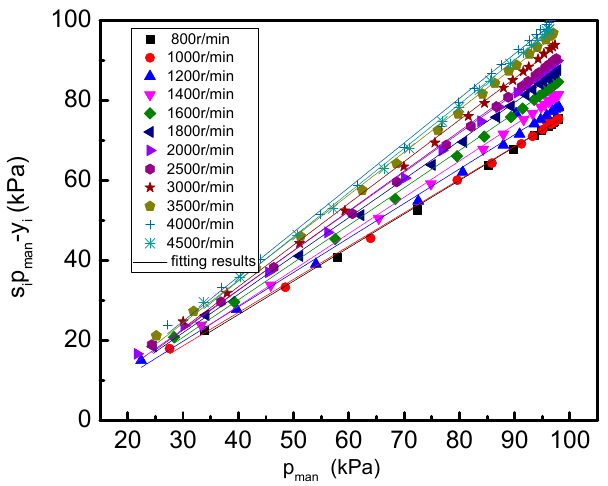
Figure 5. The fitting result of s i p man − y